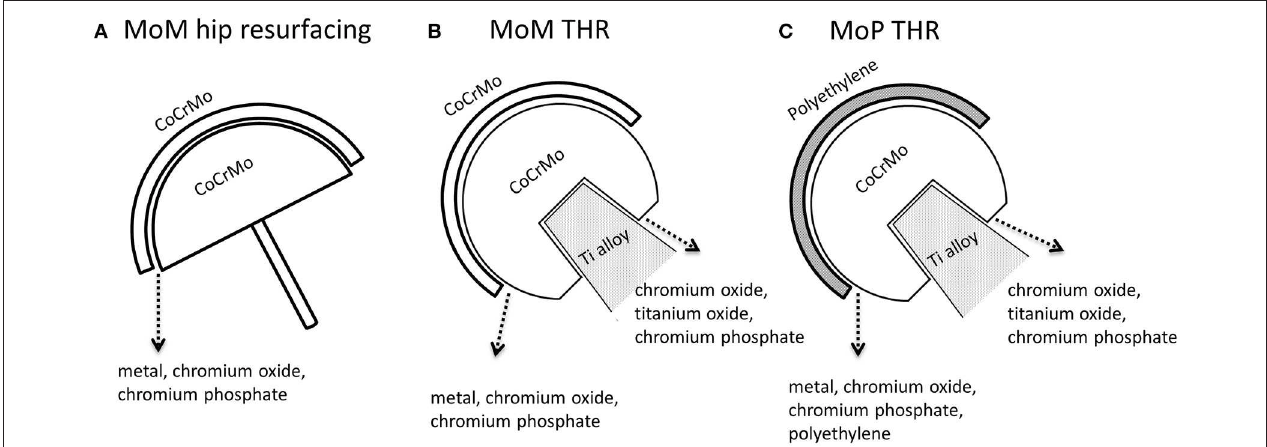
FIGURE 3 | Types of particles released from the femoral head-cup articulation and head-neck junction of CoCrMo based hip implants. (A) MoM hip resurfacing. (B) MoM total hip implant. (C) MoP total hip implant. In addition to polyethylene (PE) and titanium oxide particles, metal particles are particles with similar chemical composition to the alloy CoCrMo; chromium oxide is a type of particles containing Cr, O with low or depleted Co; chromium phosphate particles contain Cr, O, P, Ca with low or depleted Co in EDS spectrum.